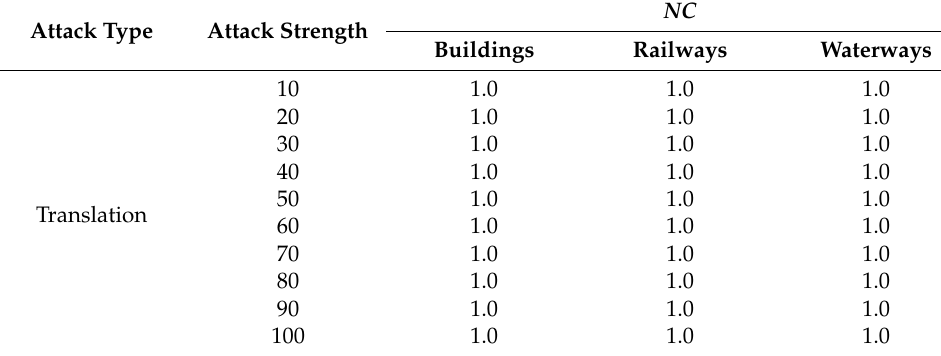
Table 10. The robustness results of translation attack.